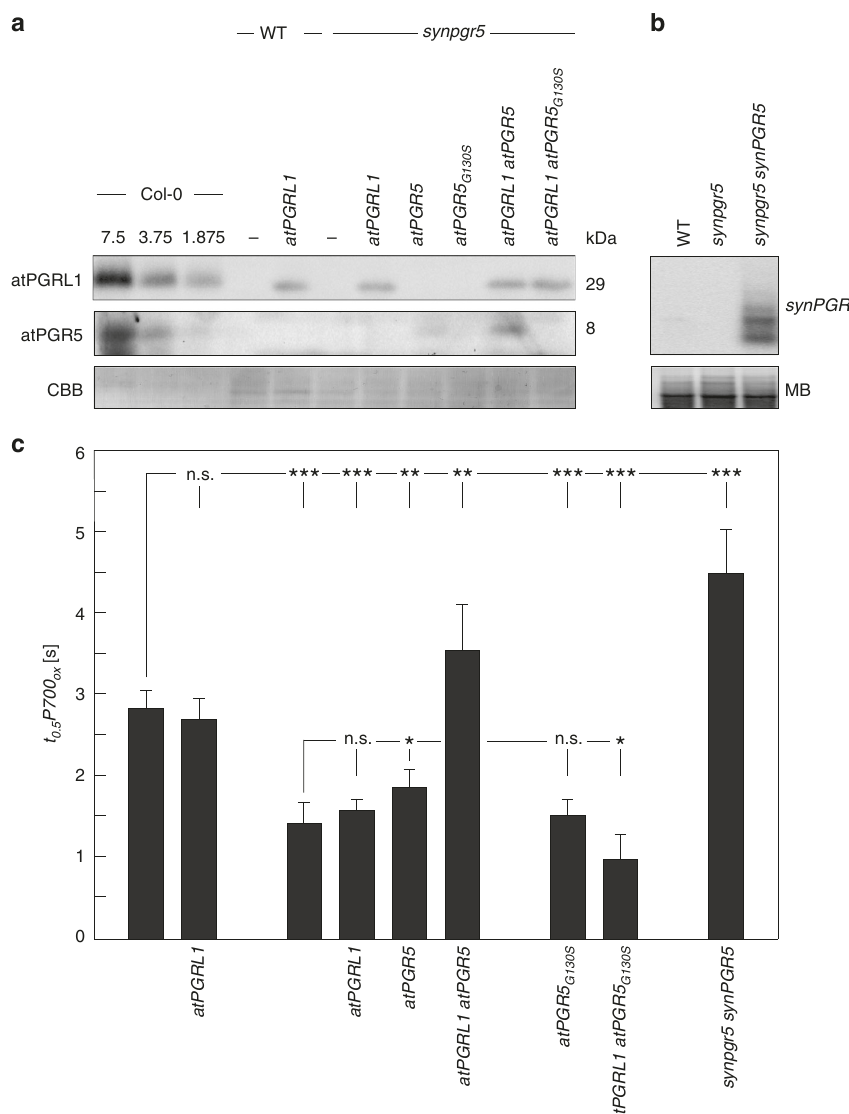
Fig. 1 Arabidopsis PGR5 and PGRL1 can restore cyclic electron fl ow in the Synechocystis synpgr5 mutant. a Immunoblot detection of atPGRL1 and atPGR5 proteins in Synechocystis strains expressing the two plant proteins either separately or together in the WT or synpgr5 background. WT and synpgr5 strains, as well as different dilutions of protein extracts from WT A. thaliana (Col-0), were employed as controls. Col-0 extracts were loaded in different dilutions corresponding to 7.5, 3.75, and 1.875 µ g of thylakoid protein, and 30- µ g aliquots of Synechocystis thylakoid proteins were loaded per lane. Staining with Coomassie Brillant Blue served as loading control. b Transcripts of synPGR5 accumulate to much higher levels in the synpgr5 synPGR5 strain than in the WT, as determined by Northern analysis using a synPGR5 -speci fi c probe. 20 µ g of total RNA were loaded per lane. Methylene blue (MB) staining served as loading control. c The bar chart shows mean t 0.5 P700 ox values (see Methods), as a proxy for the level of CEF (see text for details), for Synechocystis transformants expressing plant PGR5 and/or PGRL1 or overexpressing cyanobacterial PGR5 (synPGR5), together with the appropriate controls. Error bars correspond to the standard deviation for n = 6/6/6/4/6/3/7/16 (order as displayed) independent experiments, and statistically signi fi cant differences with respect to WT or synpgr5 according to Holm-corrected two-sided Student ’ s t -tests are indicated by asterisks ( * P ≤ 0.05, ** P ≤ 0.01, *** P ≤ 0.001, n.s., not statistically signi fi